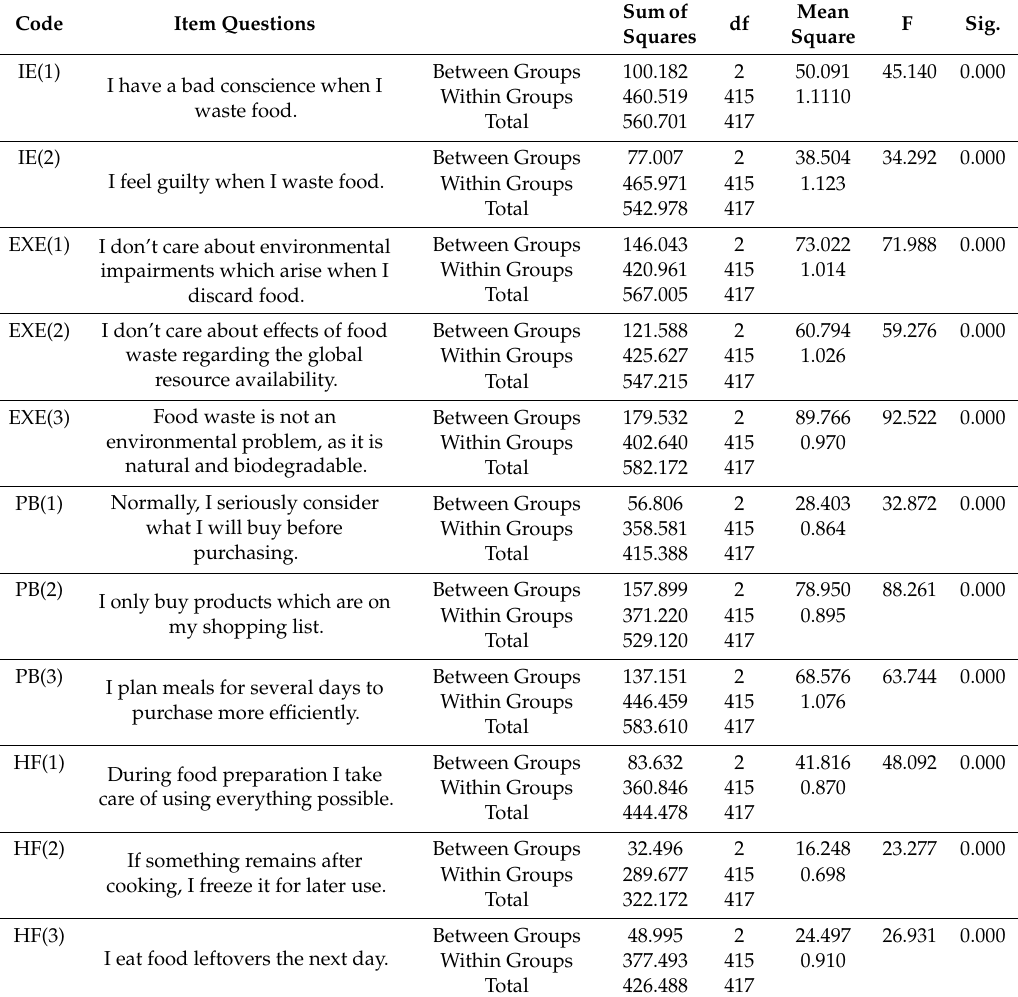
Table 3. ANOVA analysis presenting item questions and their level of significance. IE, Individual E ff ects; EXE, Exogenous e ff ects; PB, Purchase Behavior; HF, Handling Food; df, Degree of Freedom; F, f-value;